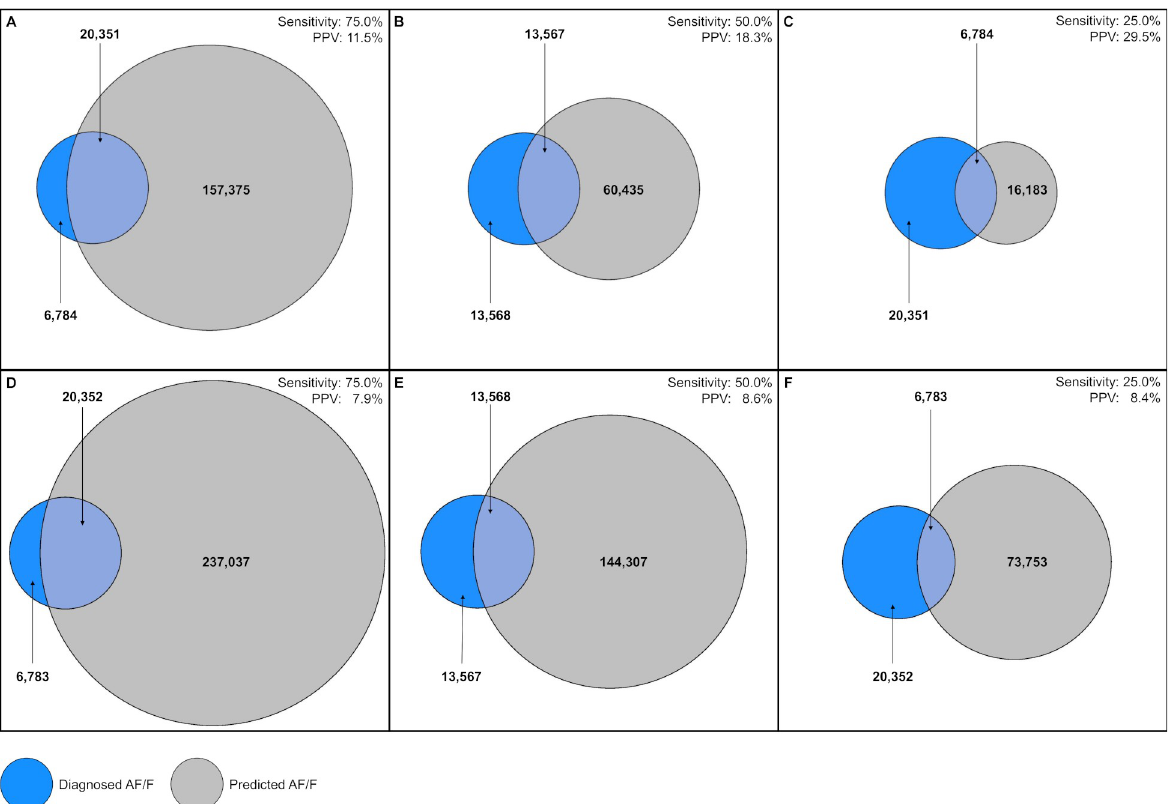
Fig 2. Illustration of the trade-off between sensitivity and positive predictive value (PPV) for the final machine learning risk model (A–C) compared with the baseline CHARGE-AF risk model (D–F).